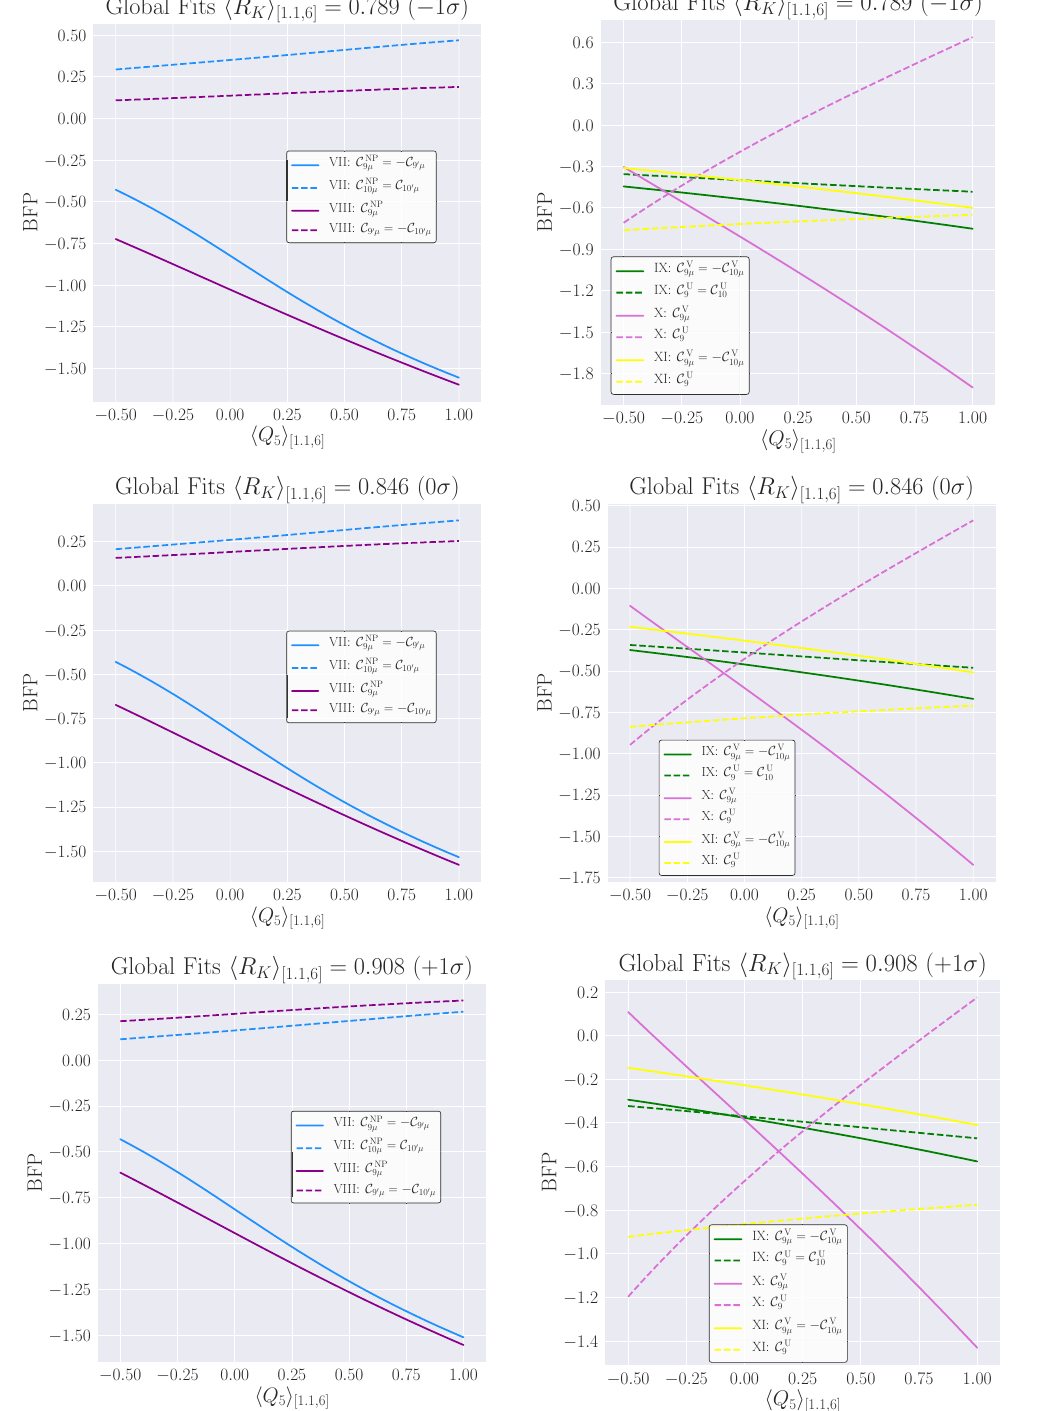
Figure 15. Global fit: impact of for different values of